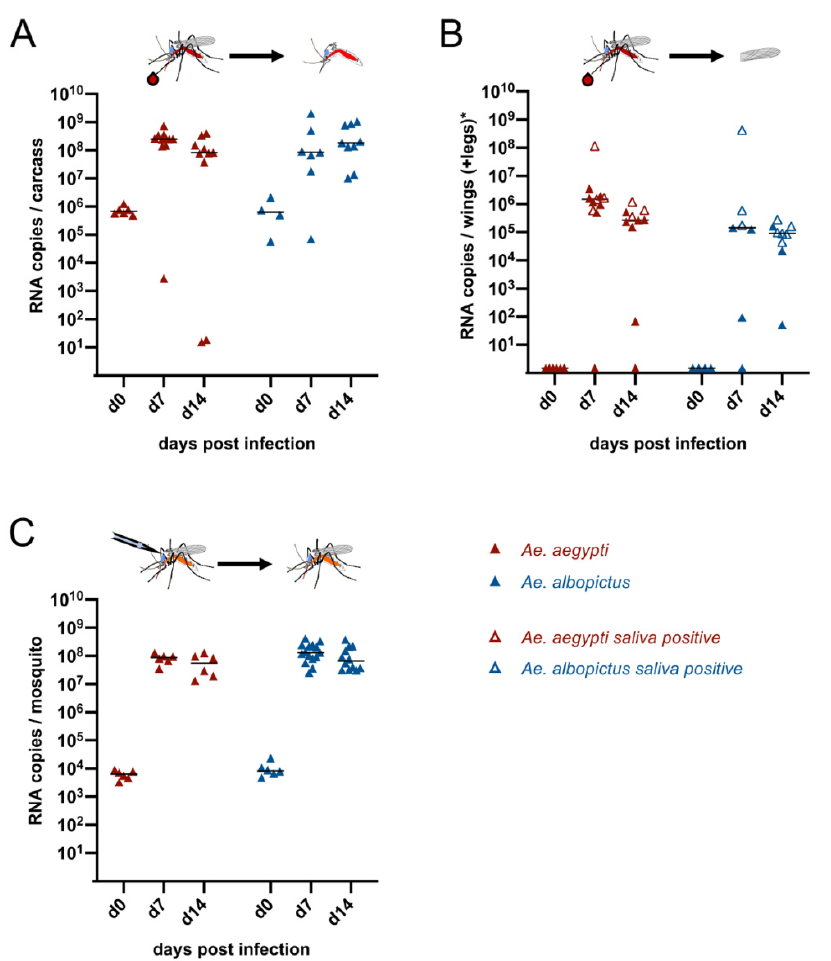
Figure 2. Infection of Ae. aegypti and Ae. albopictus with CHIKV- ∆ DR. ( A ) Infection of mosquitoes after oral feeding with blood meal containing 1 × 10 6 PFU/mL CHIKV- ∆ DR. At 0, 7 and 14 days post infection, mosquitoes were dissected and viral RNA copies were determined in the carcasses of the mosquitoes by real-time RT-PCR. ( B ) Dissemination of virus into secondary tissues after oral infection. At the indicated time points, viral RNA copies in wings and legs ( Ae. aegypti ) or wings ( Ae. albopictus ) were determined by real-time RT-PCR. Open symbols indicate disseminated mosquitoes for which transmission into saliva was also detected. ( C ) Intrathoracic infection of mosquitoes using 200 PFU of CHIKV- ∆ DR. At the indicated time points viral load in the whole mosquitoes was determined using real-time RT-PCR. Each point represents a single female mosquito. The black line indicates the median of the viral RNA copies in each